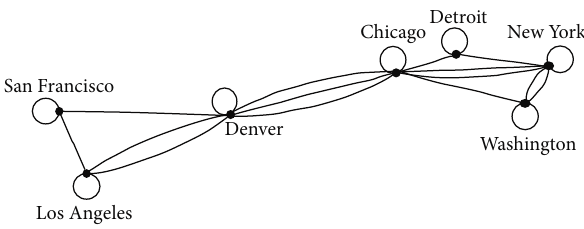
Figure 1: A computer network with diagnostic